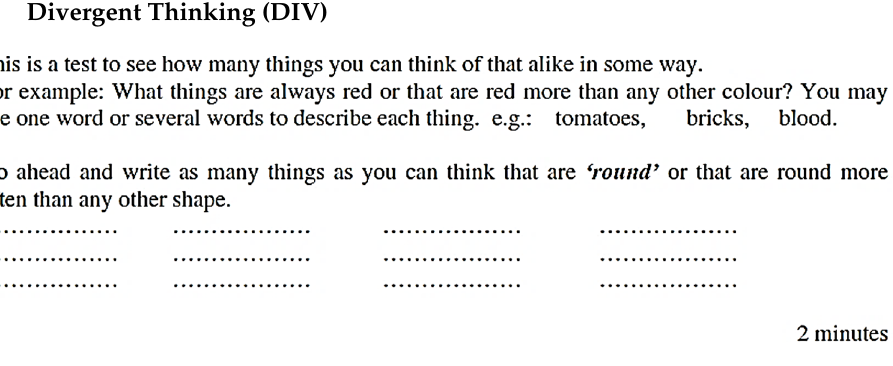
Figure A3. Sample item from the Field dependence/independence test.